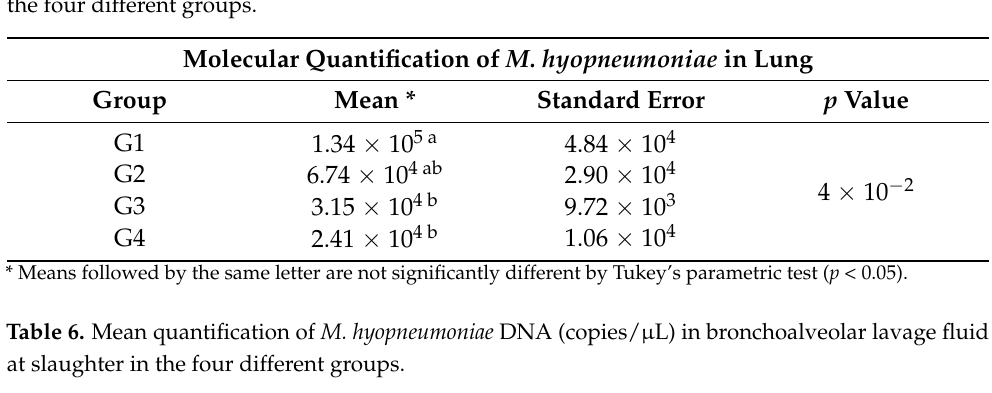
Table 5. Mean quantification of M. hyopneumoniae DNA (copies/ µ L) in lung tissue at slaughter for the four different groups.